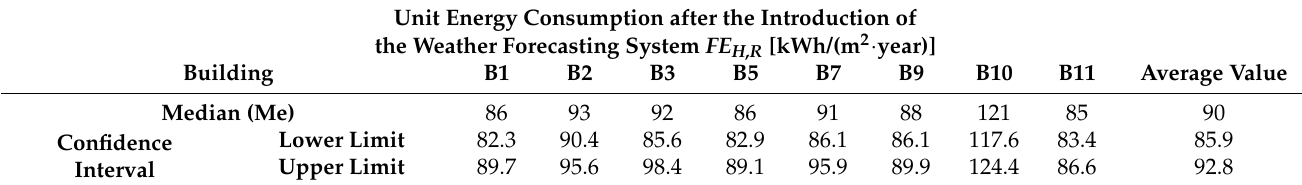
Table 6. Annual heating energy consumption index after introduction of Egain Edge system FE H ,